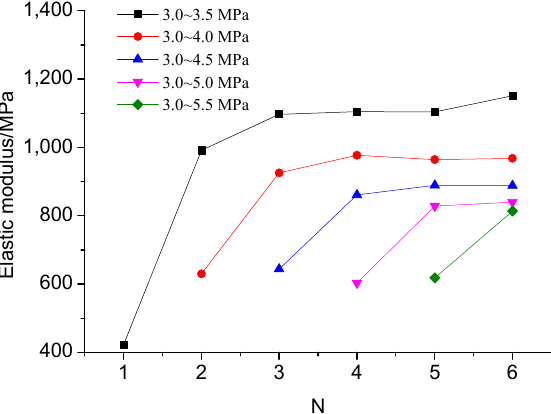
Figure 4. Relation curves between elastic modulus and cycle number in different loading stress intervals.